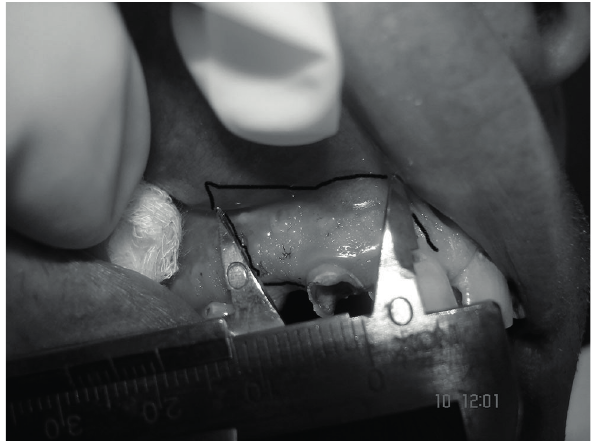
Fig. 1. The measuring